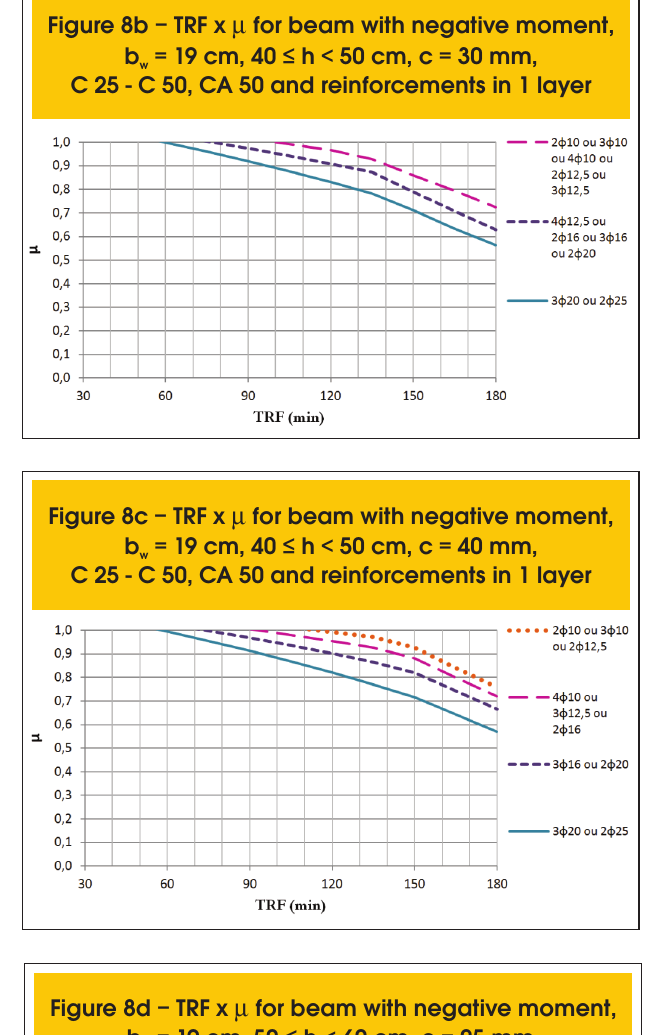
Figure 8a – TRF x m for beam with negative moment, b = 19 cm, 40 ≤ h < 50 cm, c = 25 mm, w